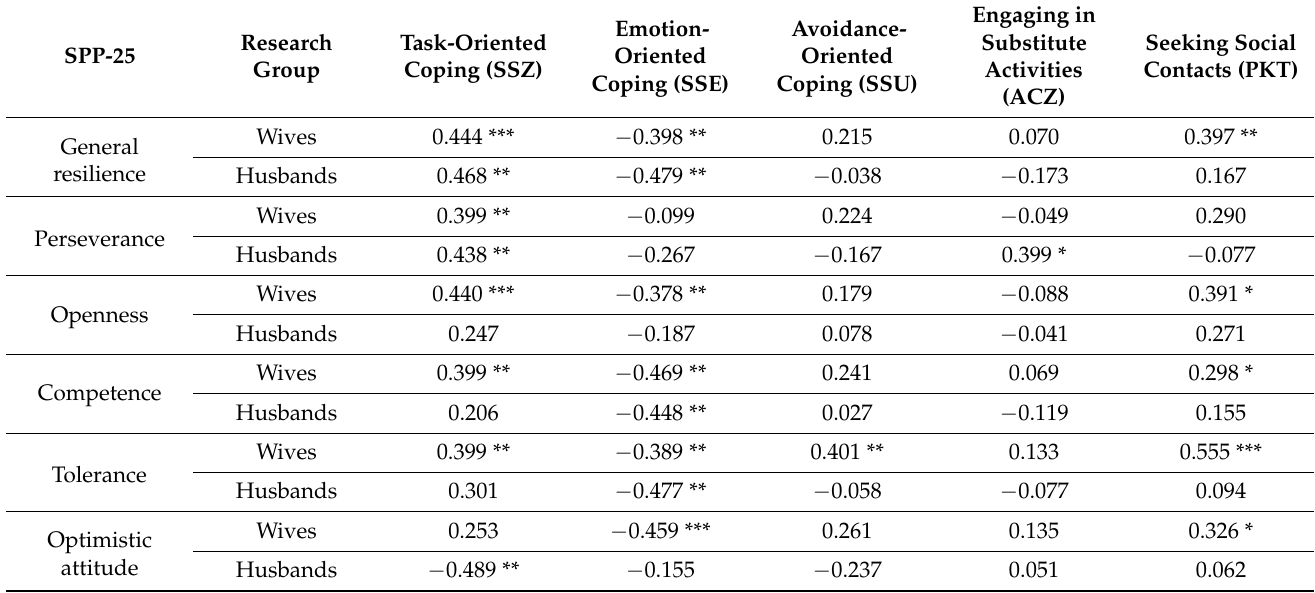
Table 2. Pearson’s r correlation coefficients between resilience and stress coping styles among the study group of wives and